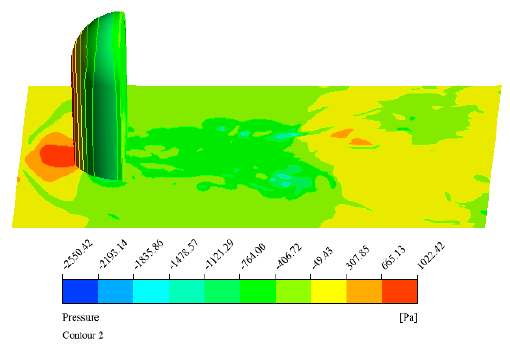
Figure 7. Pressure distribution of the side mirror and the panel.